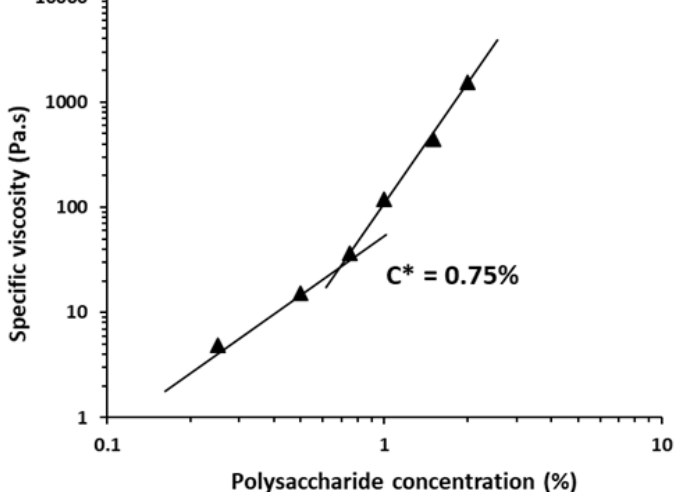
Figure 8. Storage modulus ( G’ ) and loss modulus ( G’’ ) vs. angular frequency (rad/s) for JSP aqueous solutions for different concentrations (1.0%–2.0%, w/v ) at 25 °C in water.